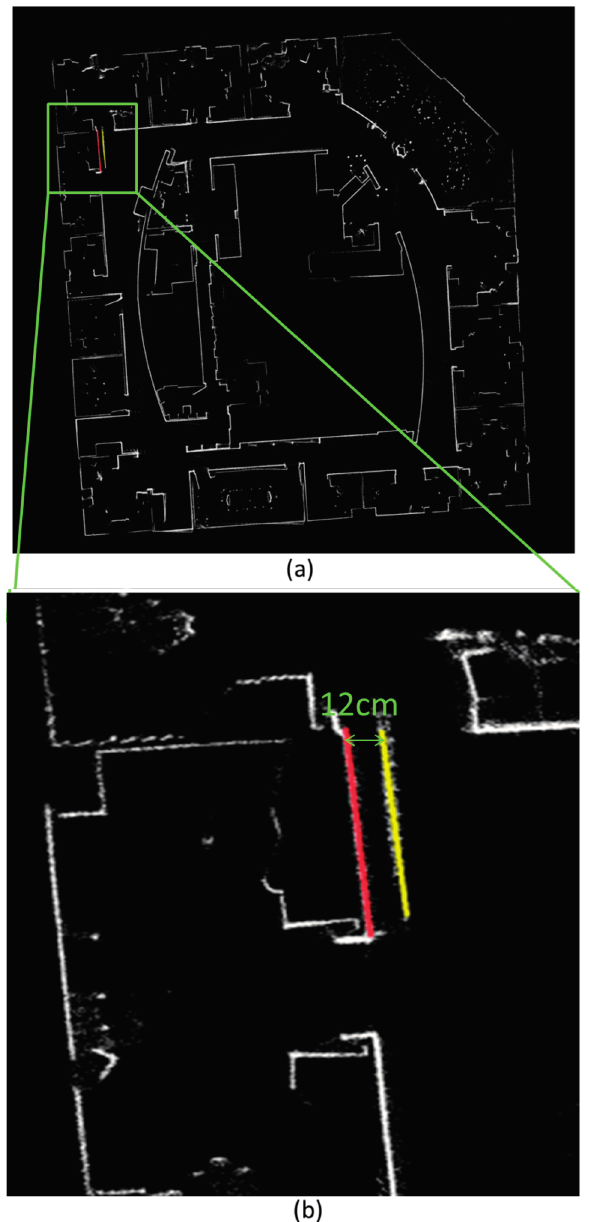
Figure 5. ( a ) Mapping error details of open dataset; ( b ) Mapping result of NAVIS